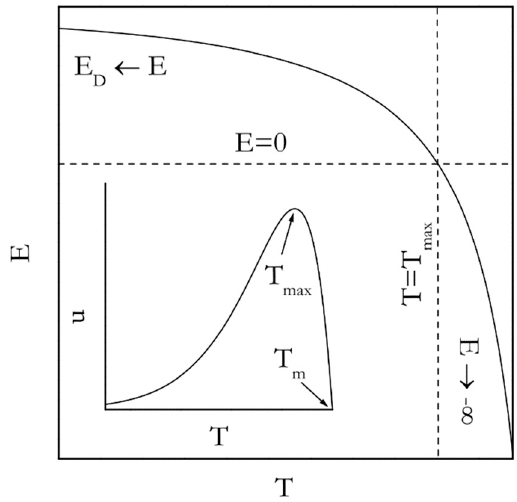
Figure 4. Temperature dependence of the activation energy according to Equation (15). Inset shows temperature dependence of the growth rate according to Equation (13).